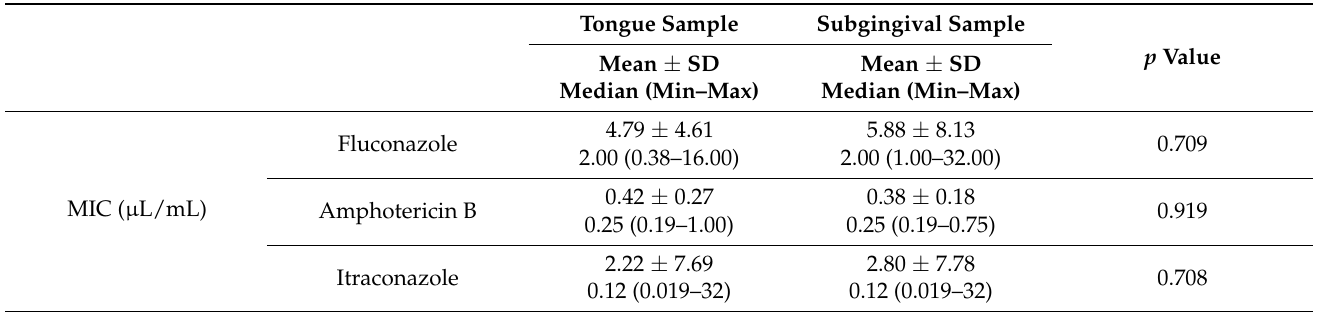
Table 2. Minimal inhibitory concentrations of Fluconazole, Amphotericin B and Itraconazole for Candida albicans isolated from the tongue and from subgingival biofilm.